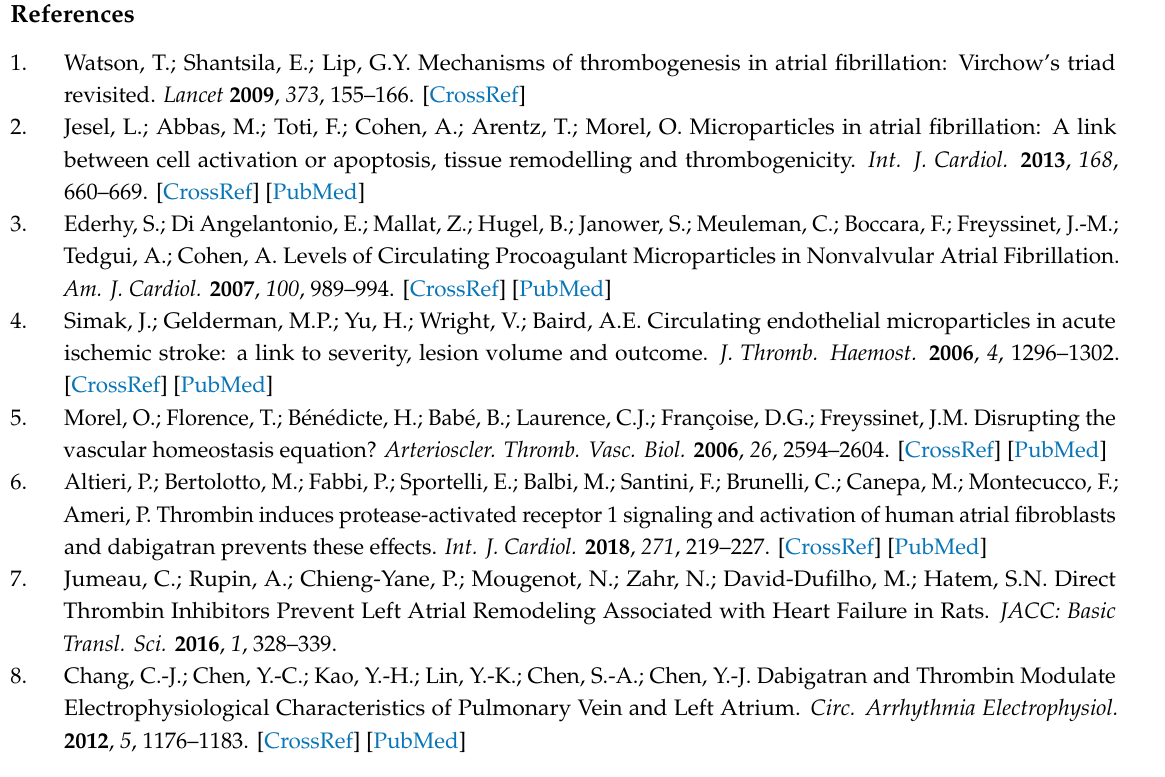
Figure S1: Immunofluorescence staining of endothelial makers in atrial endothelial